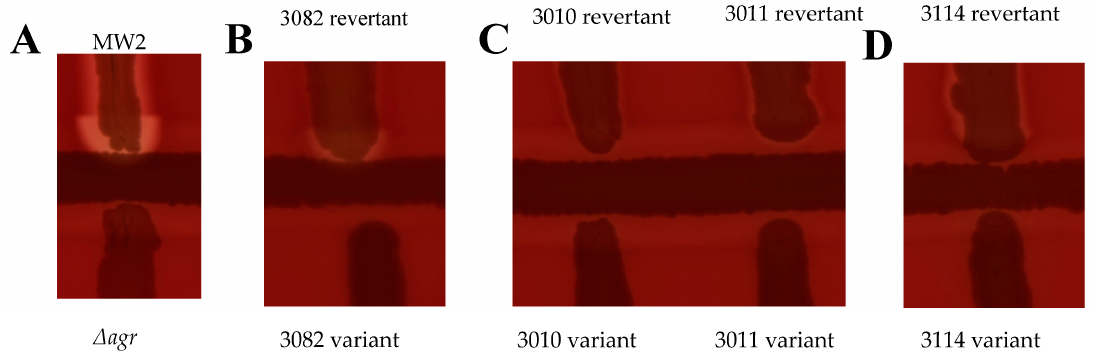
Figure 1. 10% of clinical strains showed phenotypic reversion of haemolysis on a CAMP test. ( A ) S. aureus strain MW2 as positive control for Agr activity and its isogenic agr deletion mutant as a negative control. ( B ) Strain 3082 reverted to an Agr active phenotype. ( C ) Strains 3010 and 3011 reverted a haemolytic phenotype, but Agr activity was unaffected. ( D ) Strain 3114 reverted to an α - haemolysin producing phenotype, indicated by the inhibition of haemolysis at the convergence with the hlb producer but strong haemolysis